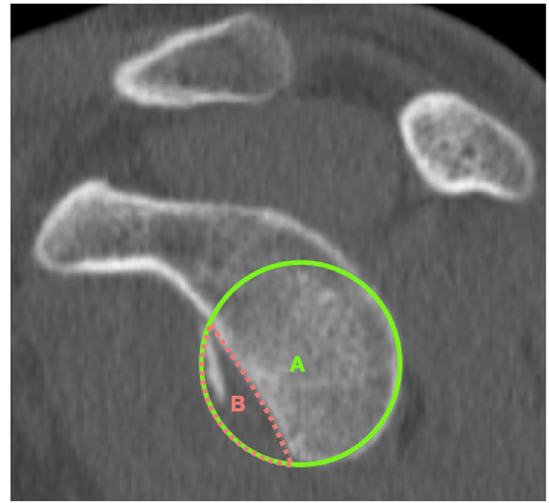
Fig. 1 a CT en-face image of the left shoulder of a subject with anterior shoulder instability and apparent anterior glenoid bone loss. The glenoid bone defect is measured using the PICO method. A best-fit circle is drawn around the posteroinferior cortical margin of the glenoid. The defect is manually drawn and measured using the area tool